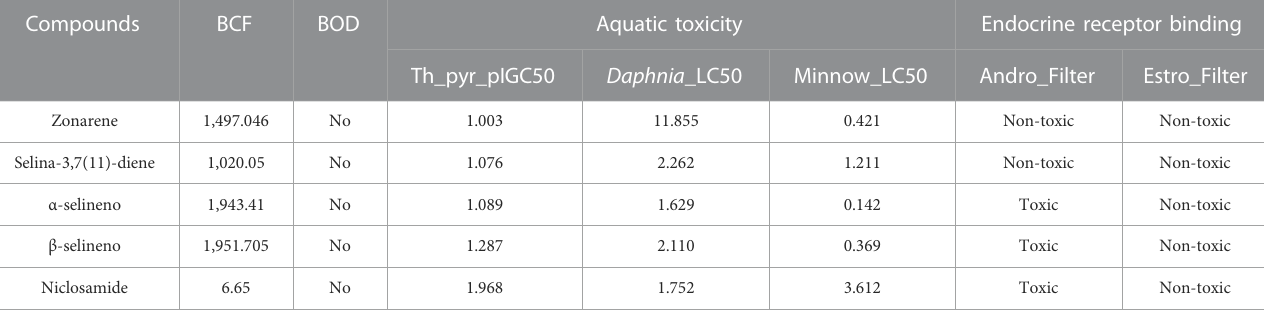
TABLE 4 Results of the compound ecotoxicity. The endpoints legend evaluated for each compound are de fi ned: BCF, bioconcentration factor value; BOD, biodegradation — categorize the compounds as positive (readily biodegradable) if %biodegradation is greater than or equal to 60% and as negative otherwise; Th_ pyr_pIGC50, concentration of toxicant needed to inhibit 50% growth (IGC50) of Tetrahymena pyriformis after approximately 40 h of exposure; Daphnia_LC50, concentration(mg/L)ofcompoundrequiredtokill50%ofa D.magna population;Minnow_LC50,concentration(mg/L)ofacompoundthatkills50%ofapopulationof minnows; Andro_Filter and Estro_Filter, assess a compound ’ s likelihood of binding to the androgen/estrogen receptor.